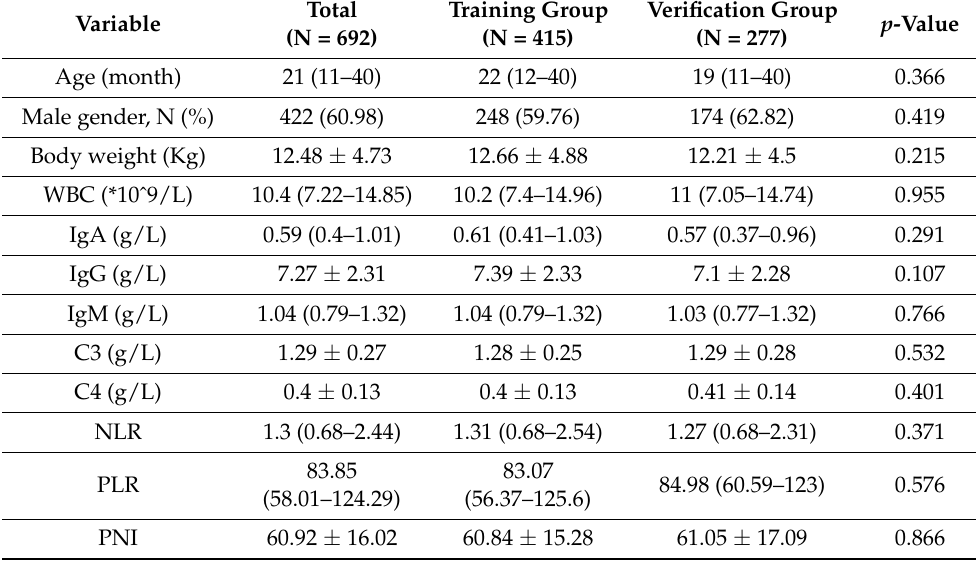
Table 1. Comparison of the variables between the training group and the verification